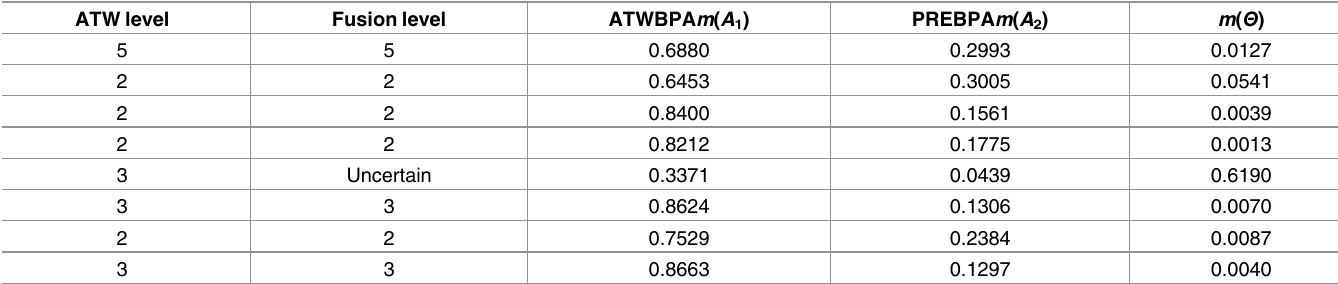
Table 9. The fusion results of the contradictory